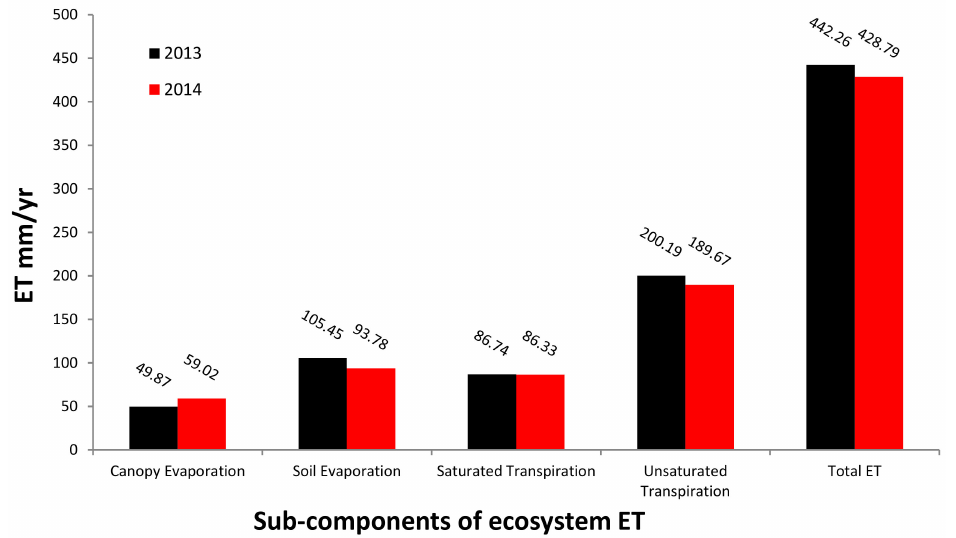
Figure 7. Simulated magnitudes of ecosystem ET sub-components in the Arou footprint area in 2013 and 2014, between DOY 1 and